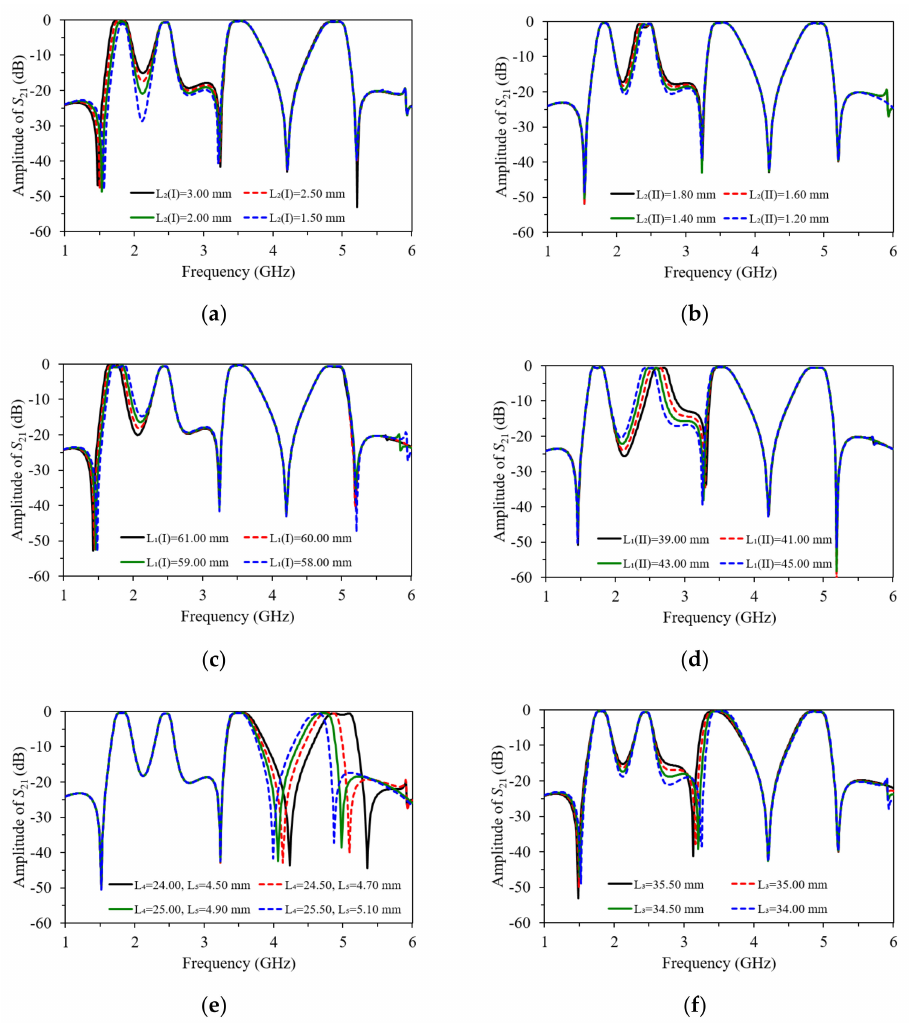
Figure 4. Variation on resonant frequency of the proposed resonator with different parameters: ( a ) L 2 I ; ( b ) L 2 II ; ( c ) L 1 I ; ( d ) L 1 II ; ( e ) L 4 and L 5 ; ( f ) L 3